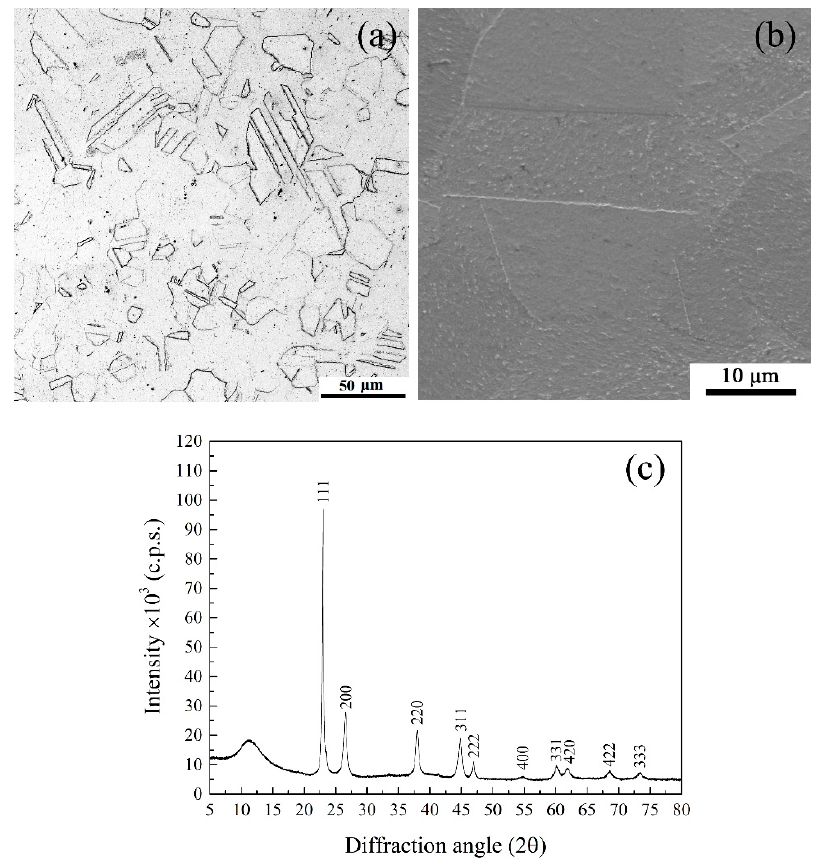
Figure 1. The investigation of the HEA after solution treatment at 1323 K, for 1 h: ( a ) OM, ( b ) SEI, and ( c ) XRD. Note that the unmarked broad peak at approximately 11 degrees of the diffraction angle is the signal from the quartz tube.